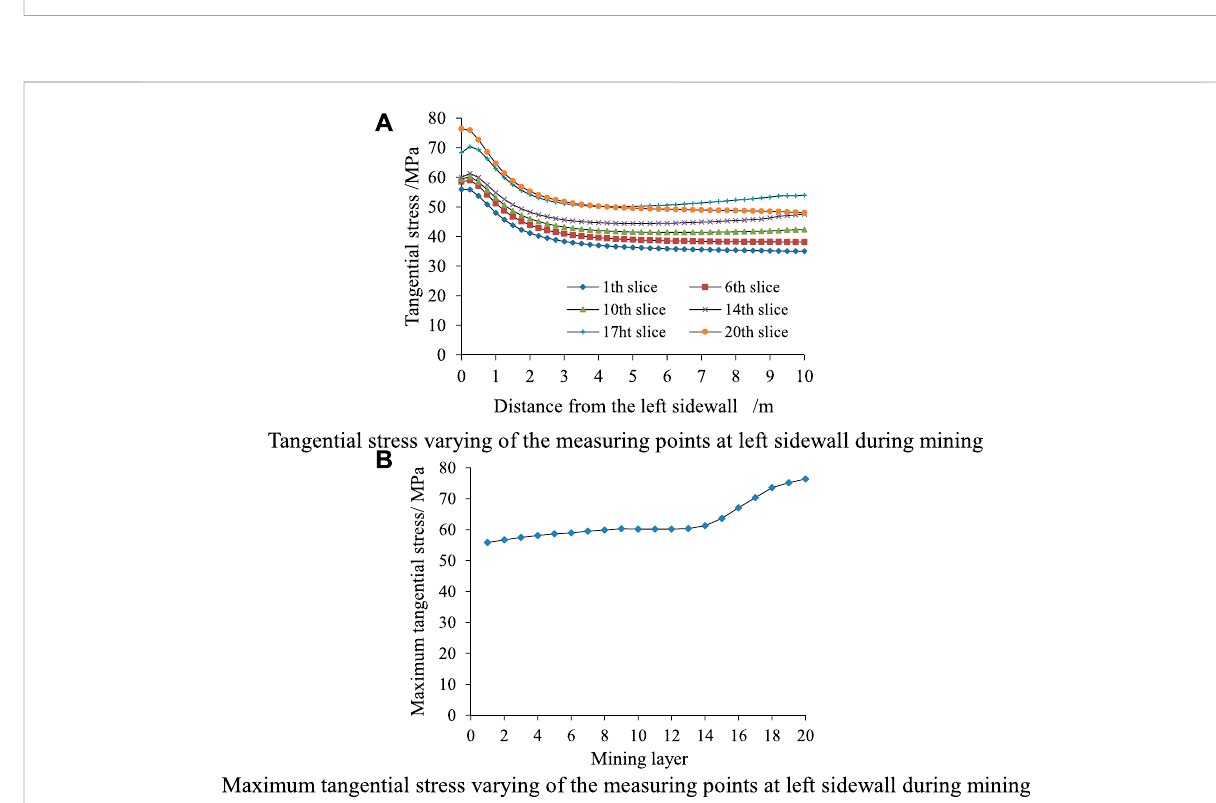
FIGURE 6 Tangential stress varying at left sidewall during